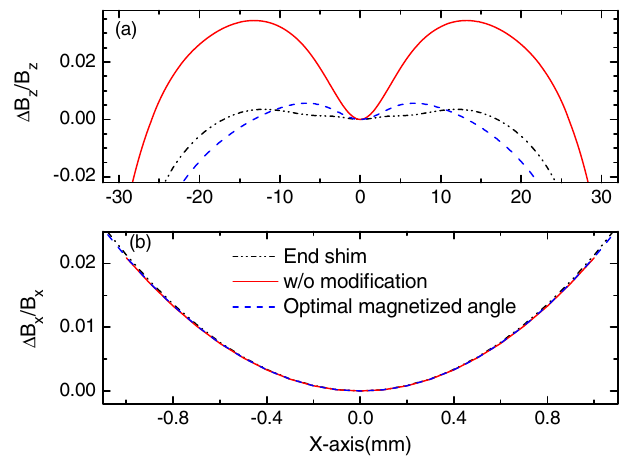
FIG. 5. Distribution of roll-off of (a) vertical field and (b) horizontal field, in the original design without modification, with an added shim at the magnet edge, and with an optimum angle of